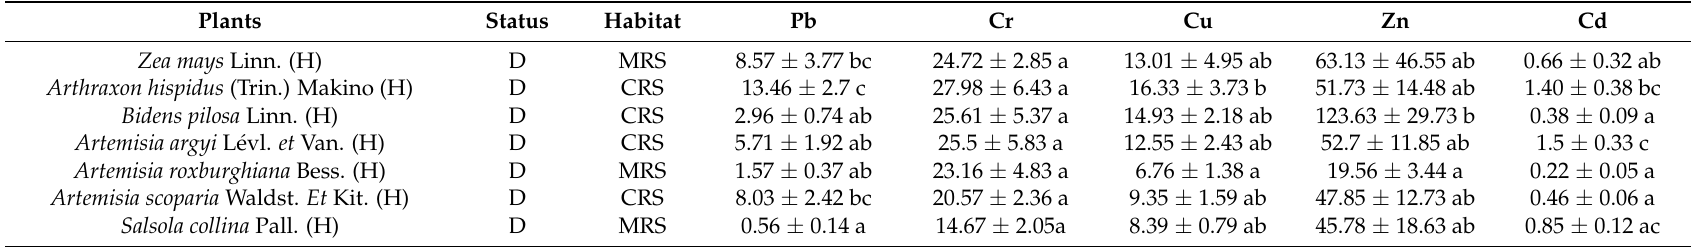
Table 4. Heavy metal concentrations of plant root part (mg · kg − 1